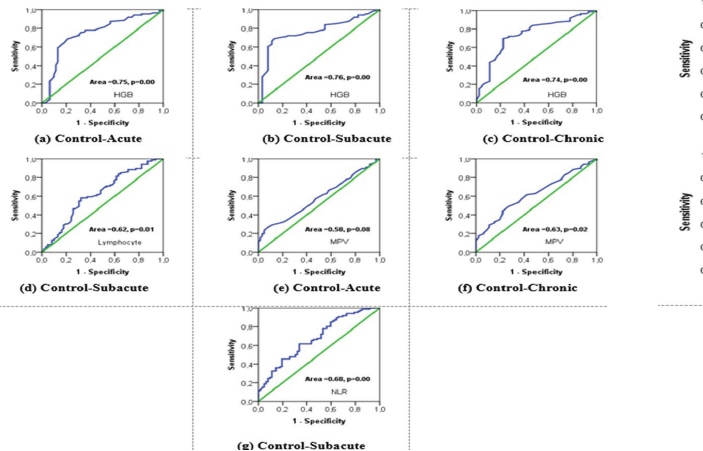
Figure 3 - The results of ROC analysis between the brucellosis group and control group for significant hematological